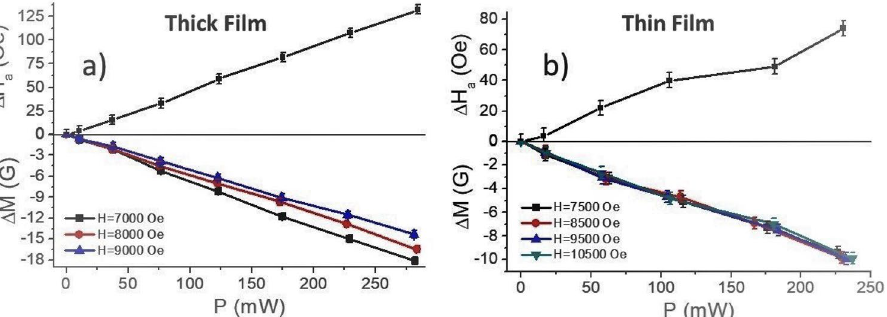
Figure 6. Variations in the saturation magnetization and the uniaxial anisotropy field due to NLME in ( a ) thick film and ( b ) thin film of barium